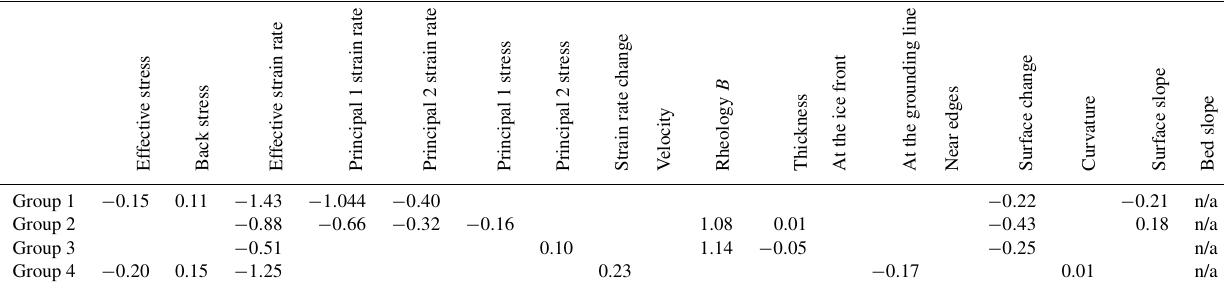
Table 5. Same as Table 4 but for floating